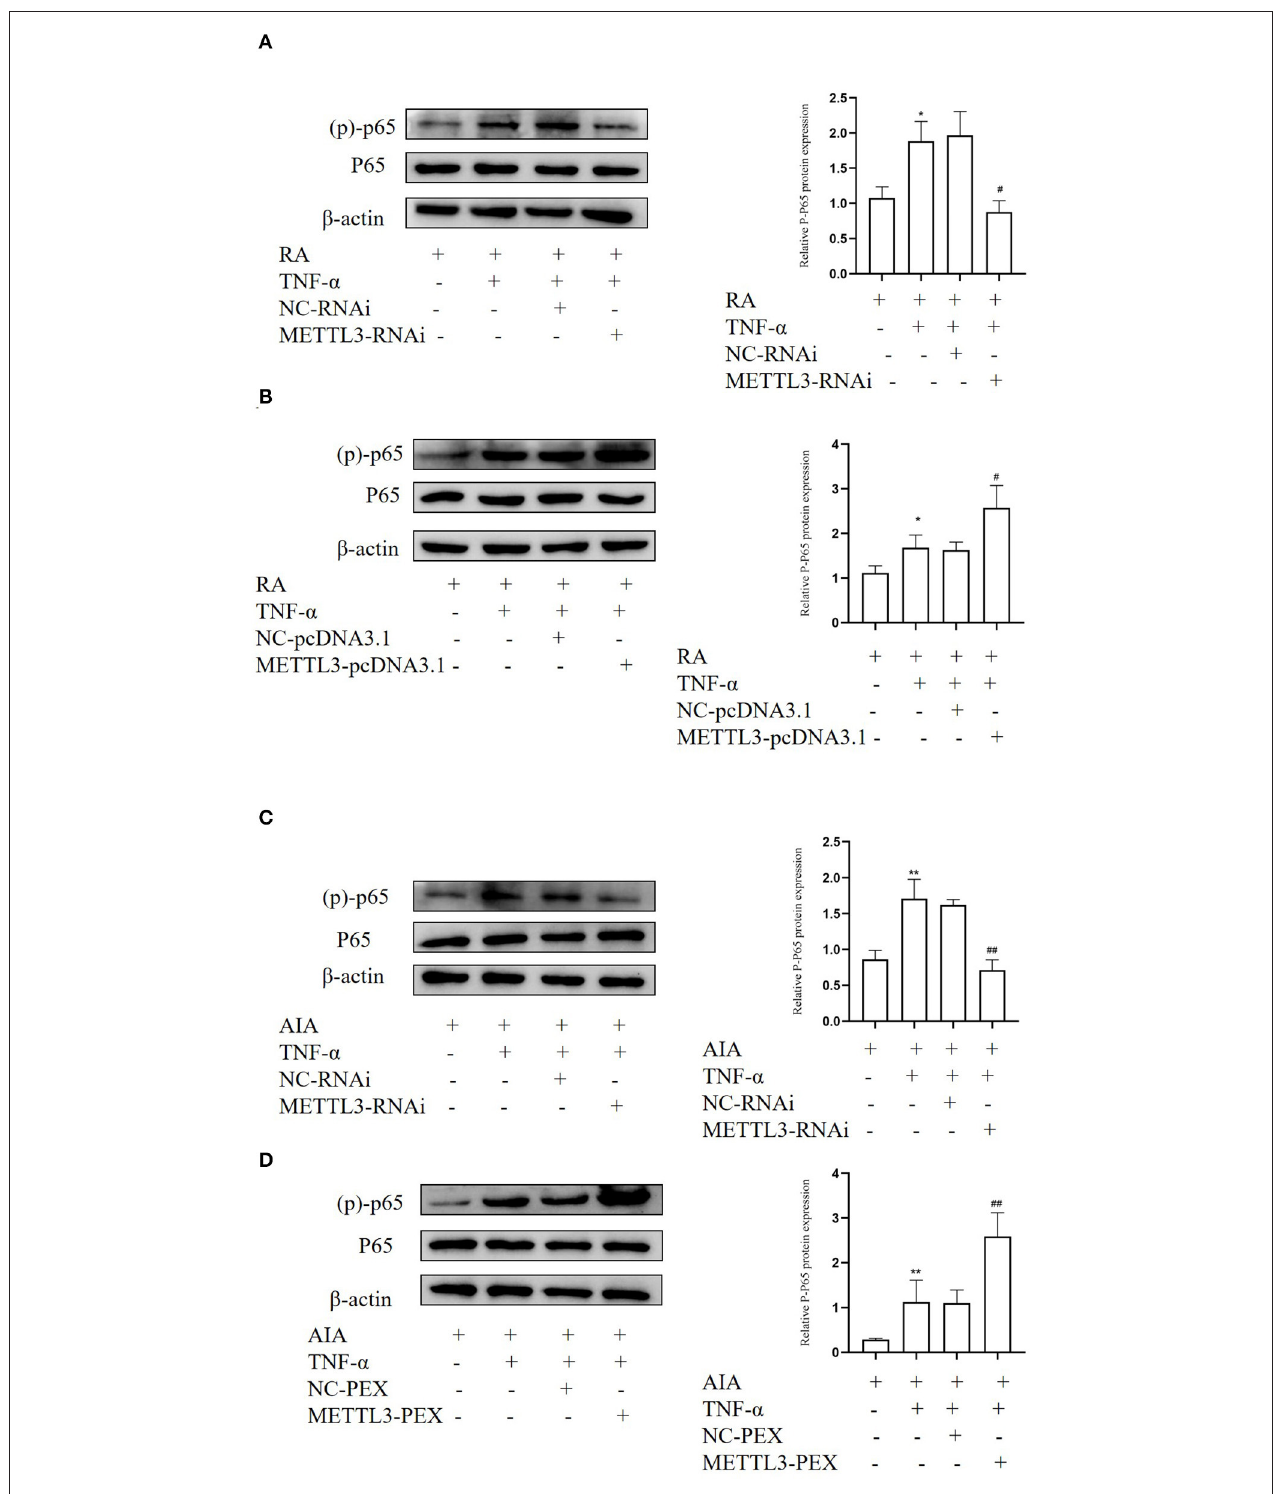
FIGURE 9 | Methyltransferase-like 3 (METTL3) plays an important function in rheumatoid arthritis (RA) may be via the NF- κ B signaling pathway. (A) Western blotting was used to measure (p)-p65 protein level in TNF- α -incubated RA-fibroblast-like synoviocytes (FLSs) after transfection with METTL3-RNAi. (B ) Western blotting was used to detect (p)-p65 protein levels in TNF- α -incubated RA-FLSs after METTL3 overexpression. (C) Western blotting was used to detect (p)-p65 protein levels in TNF- α -incubated adjuvant-induced arthritis (AIA)-FLSs after METTL3 silencing. (D) Western blotting was used to measure (p)-p65 protein levels in TNF- α -incubated AIA-FLSs after METTL3 overexpression. All of these values are presented as the mean ± SD. NC , negative control. * P < 0.05, ** P < 0.01 vs. the control group. # P < 0.05, ## P < 0.01 vs. the NC group.